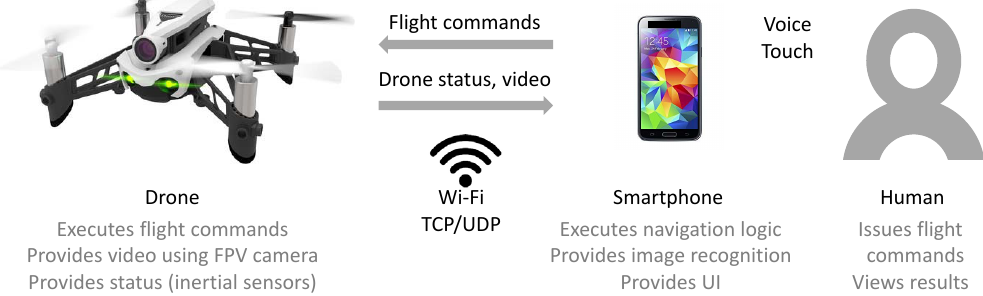
Figure 2. Distributed architecture for human-drone teaming in the concrete case of a camera-equipped drone and a smartphone app providing the user interface for the human.